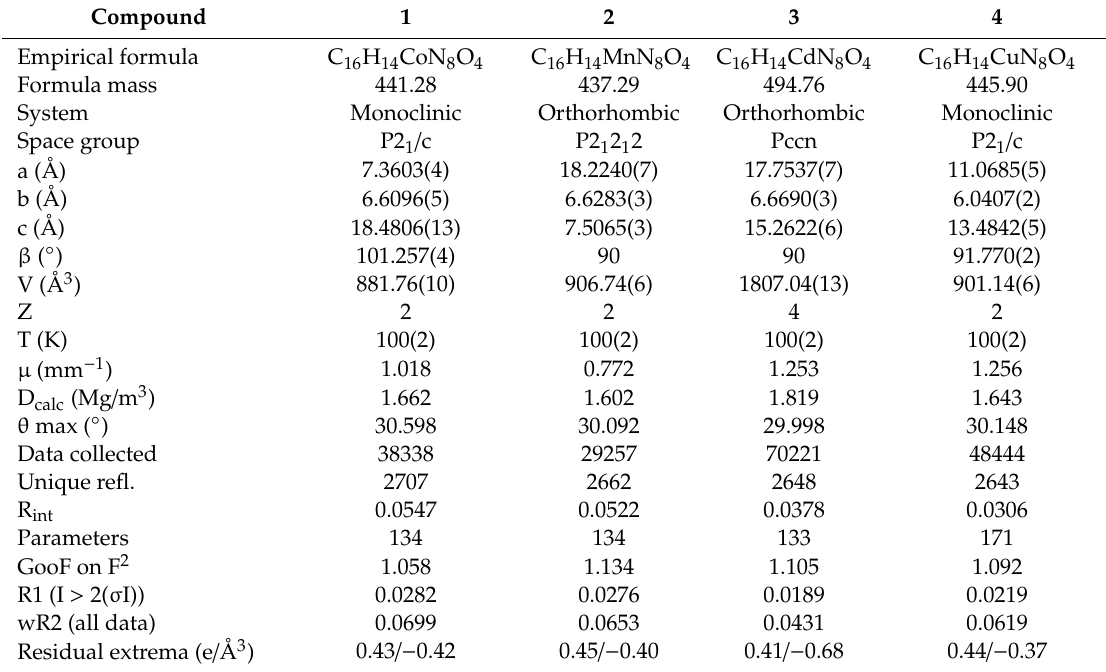
Table 2. Crystallographic data and processing